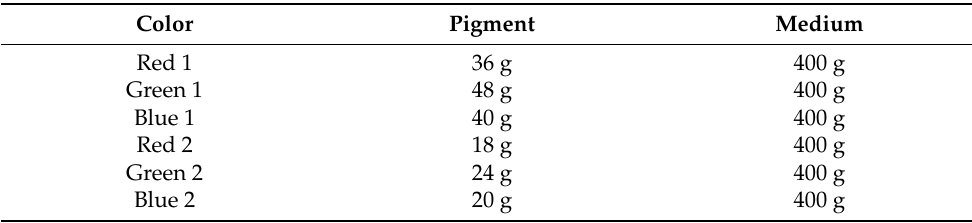
Table 3. Content of Spectraval TM pigment and medium in screen printing inks. Color